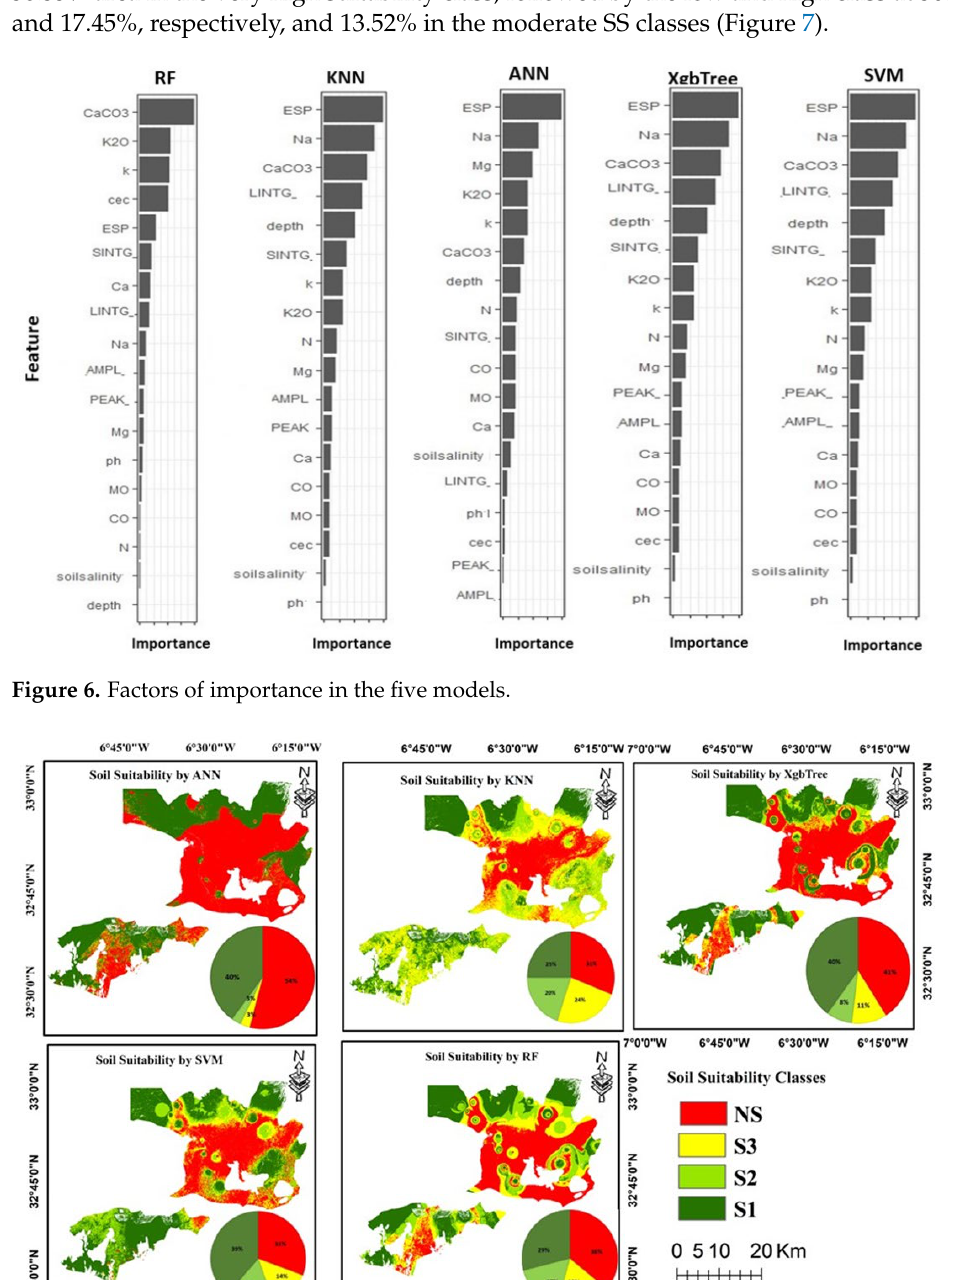
Figure 7. Soil Suitability maps using ML Models.